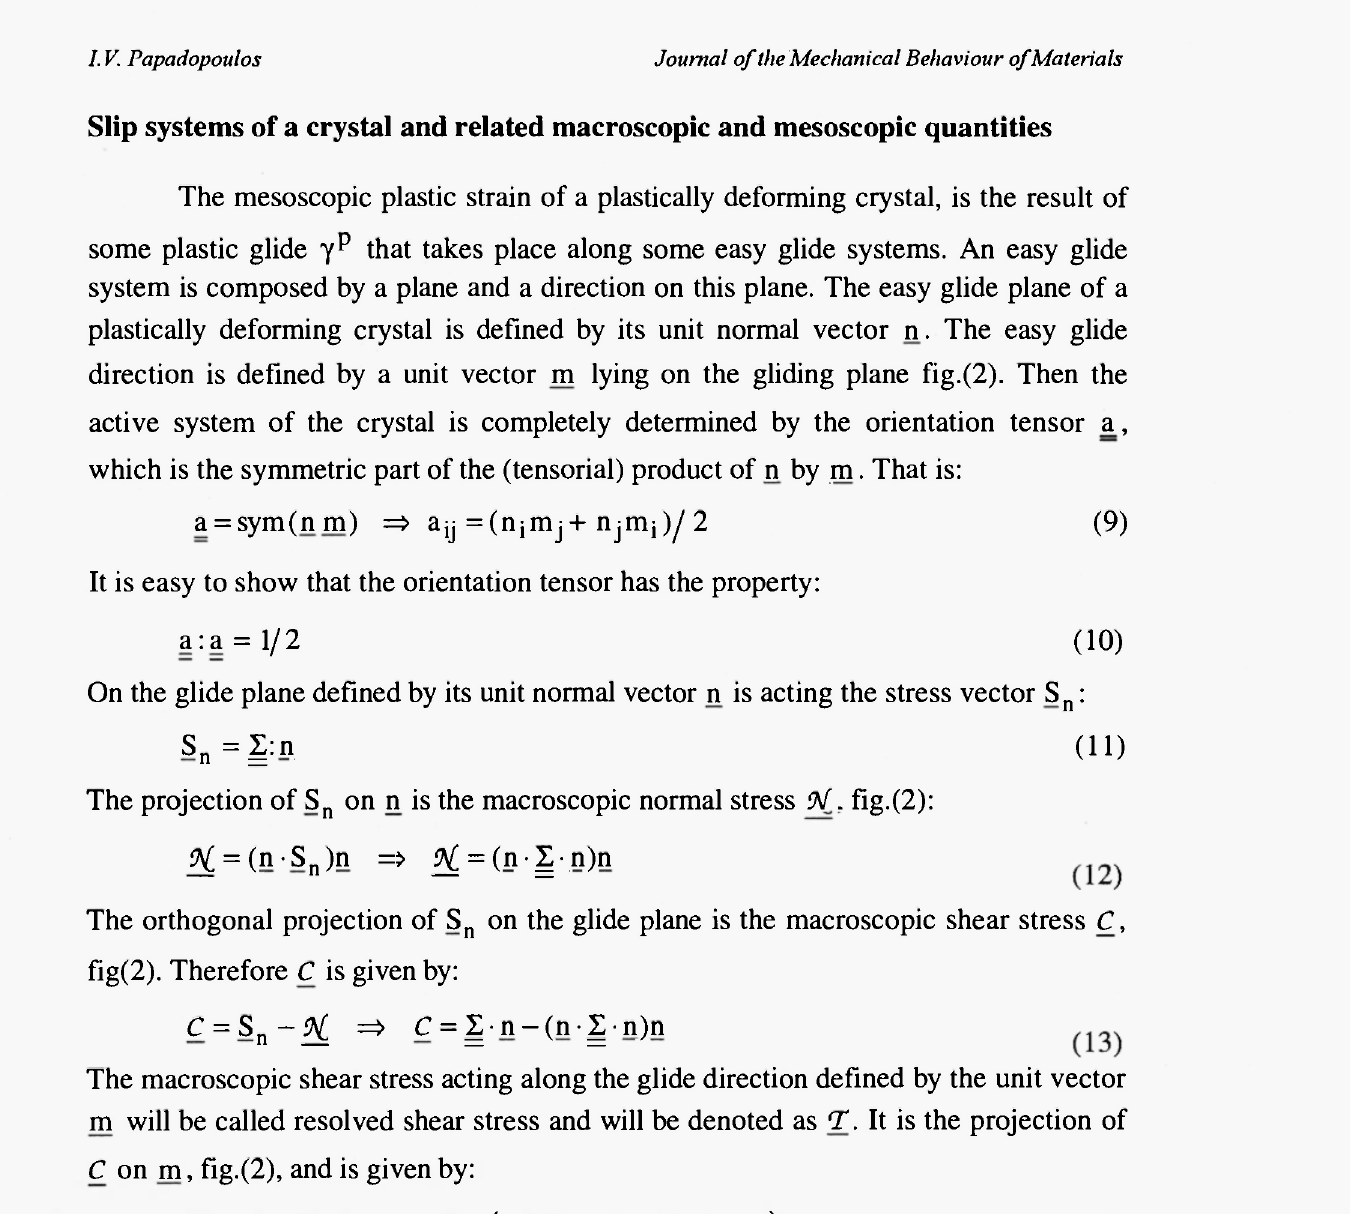
Figure 2. Normal and shear stress C acting on a plane Δ. Resolved shear stress Τ acting along a line L of